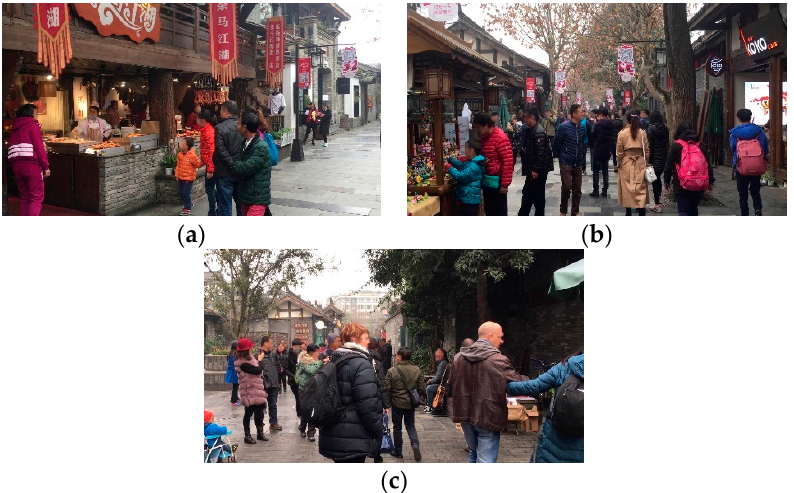
Figure 2. Photos of the Di zone ( a ), the Sp zone ( b ) and the Pe zone ( c ) in Kuan Alley.